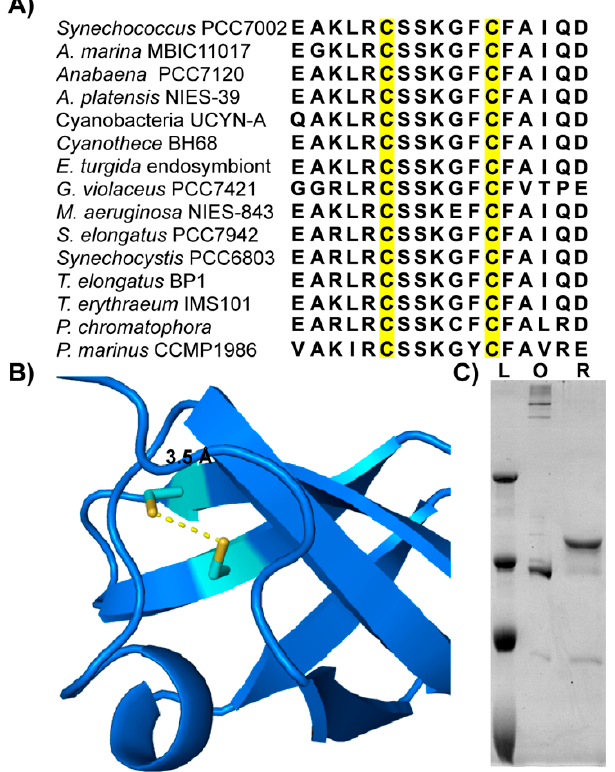
Figure 2. Identification of Redox-Active Cysteines in Zam: ( A ) Multiple sequence alignment of cyanobacterial Zam CSD1 domain focused on the CSD1 OB-fold. Conserved cysteines are highlighted in yellow. ( B ) Threaded structure prediction of PCC 7002 Zam CSD1 domain with conserved cysteines indicated in yellow. ( C ) SDS-PAGE of purified PCC 7002 Zam in oxidizing (O) and reducing (R) conditions. A quantity of 1.3 μ M protein was incubated in 10 mM oxidized glutathione and then was diluted 1:20 in buffer without glutathione (oxidized) or in the presence of 710 mM β ME (Reduced) and incubated at room temperature for 1 h. The samples were boiled for 5 min prior to loading. Ladder (L) shows apparent molecular weights (250 kDa, 130 kDa, 100 kDa, 70 kDa). Reduced protein runs at an apparent higher molecular weight.